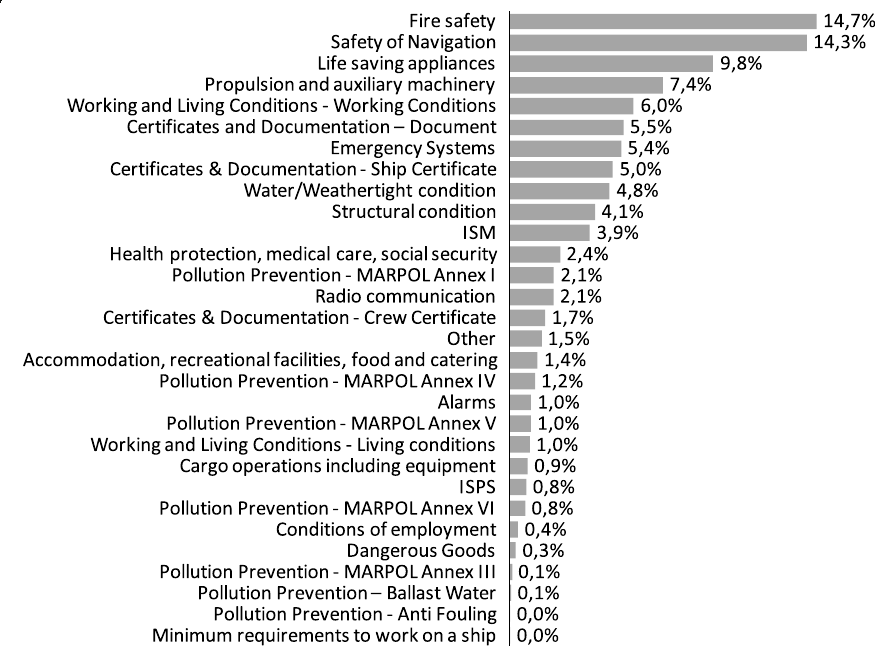
Fig. 6 Frequency of findings per Deficiency Category in considered PSC data. Source: Own